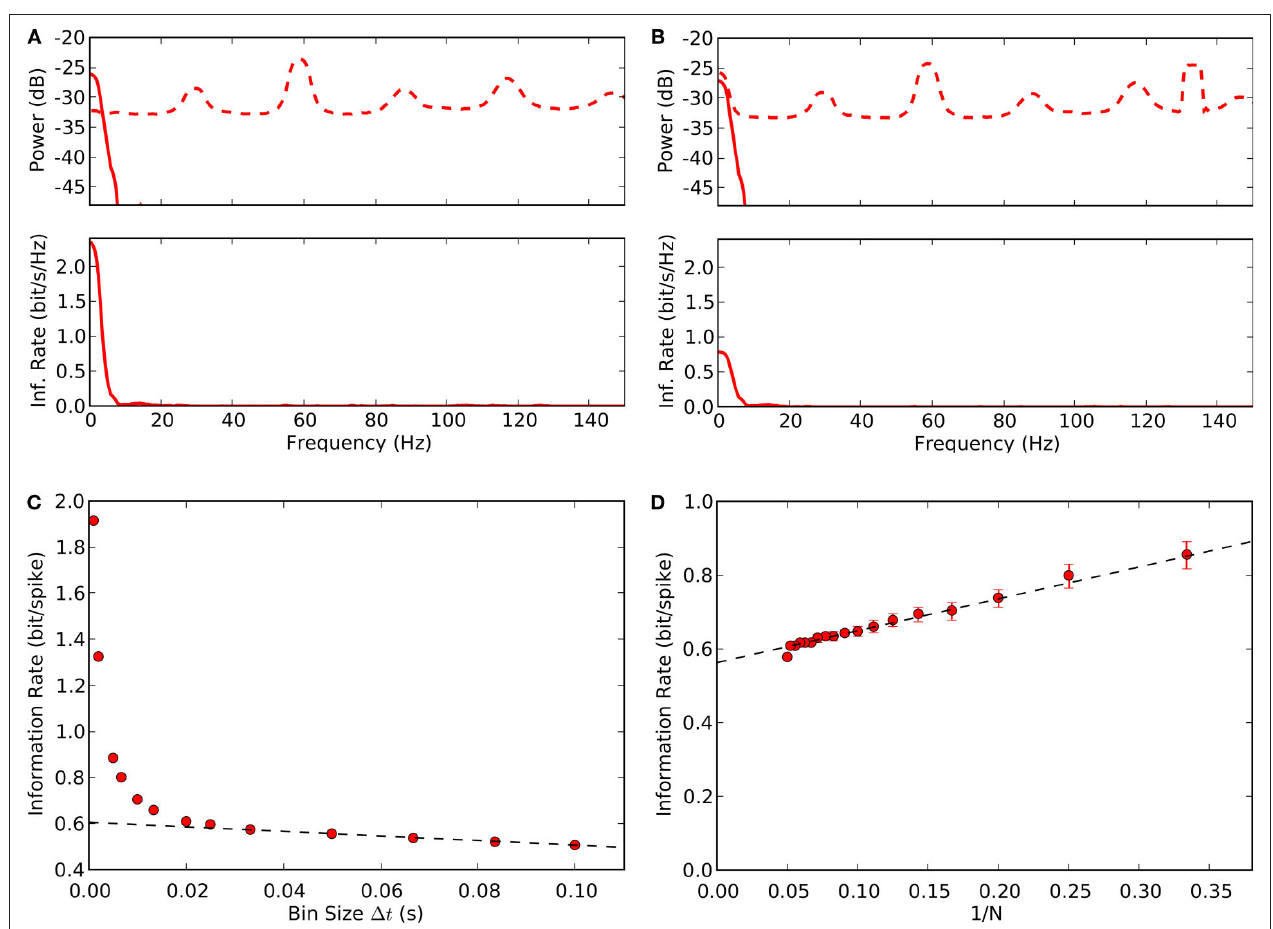
Bottom, the lower bound for spectral information rate, calculated using the stimulus reconstruction method is 5.7 bit/s, or 0.3 bit/spike. (C) Information per spike as a function of bin width Δ t ; linear extrapolation ( Δ t → 0) yields an information rate of 0.58 bit/spike. (D) Direct information estimate as a function of number of trials N; linear extrapolation ( Δ t , 1/ N → 0) yields 0.56